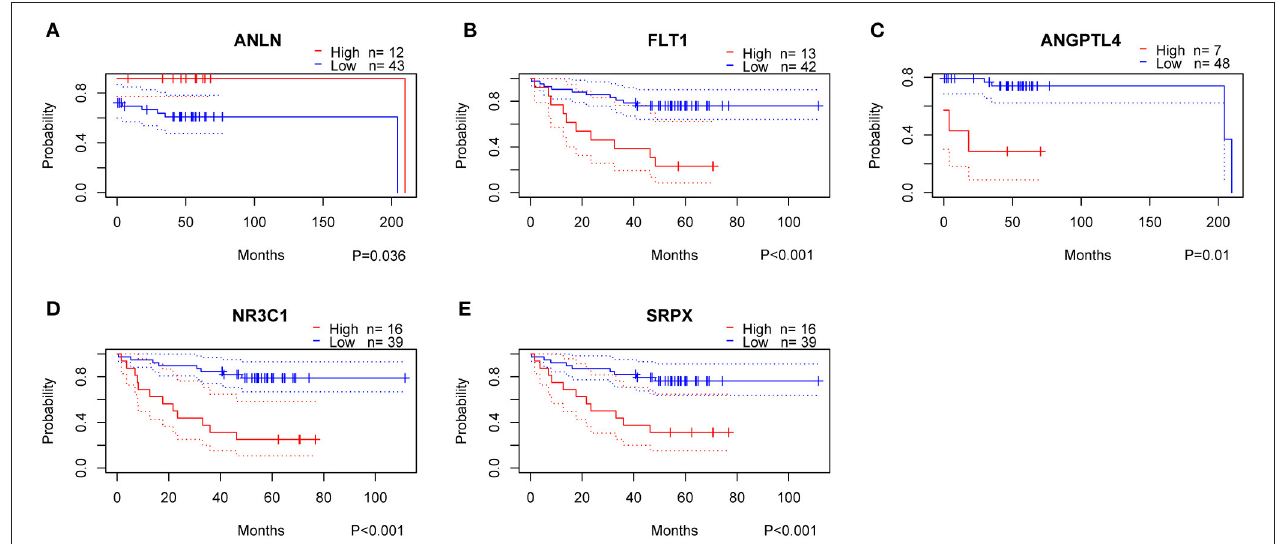
FIGURE 9 | Validation of prognostic genes using data from the GEO database. High, High Expression; Low, Low